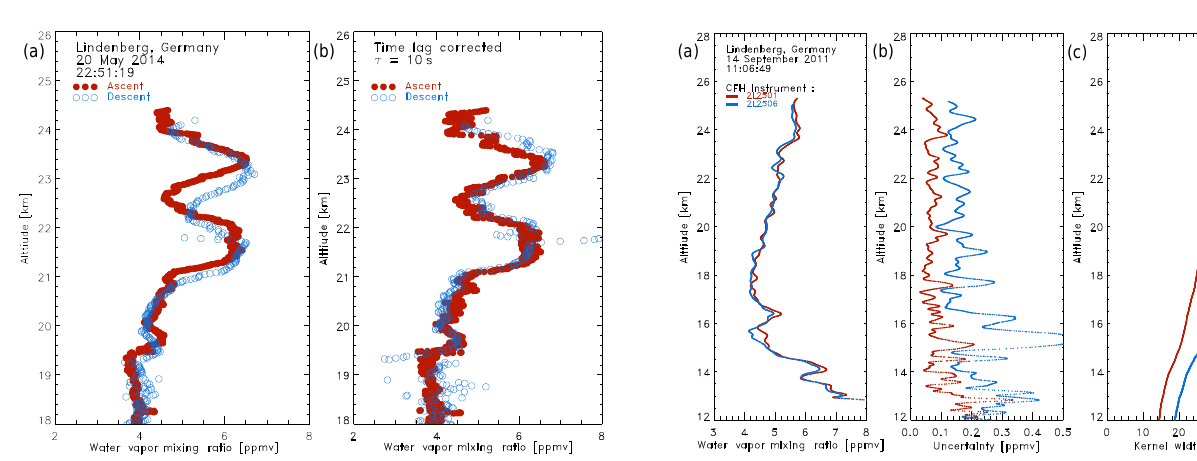
Figure 3. Profiles shown in Fig. 1, now smoothed using the Gaus- sian filter. The left panel shows the filtered profiles, the center panel their respective uncertainties, and the right panel their respective kernel widths.